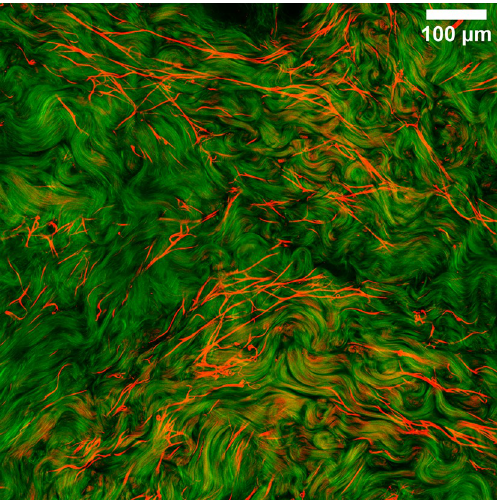
Figure 9. In-plane image of an optically-clarified reticular dermis sample observed in multiphoton through the 2PEF channel (red) revealing mostly elastic fibers and the SHG channel (green), revealing collagen